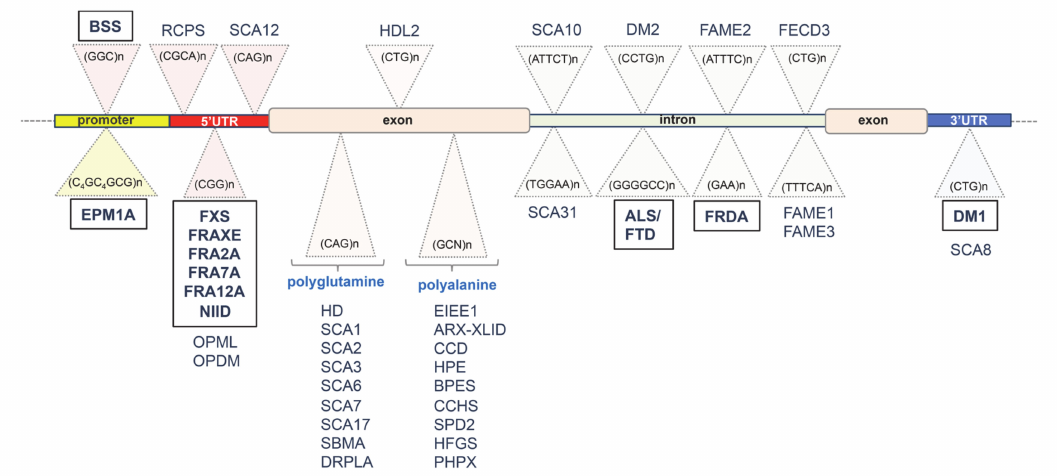
Figure 1. To date, more than 40 repeat loci have been identified: diseases and expanded repeats locations (in 5 (cid:48) or 3 (cid:48) regulatory elements, triplet tracts encoding homo-amino acid tracts and